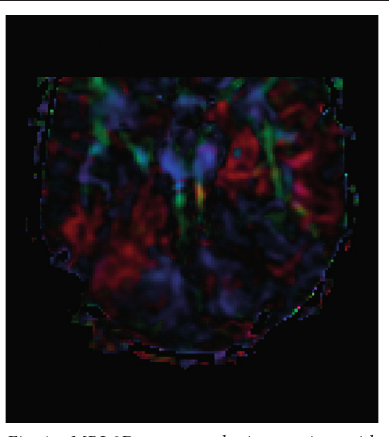
Fig. 1c. MRI 2D tractography in a patient with JSRD demonstrates lack of superior cerebellar peduncle decussation, i.e. the absent focal red dot.